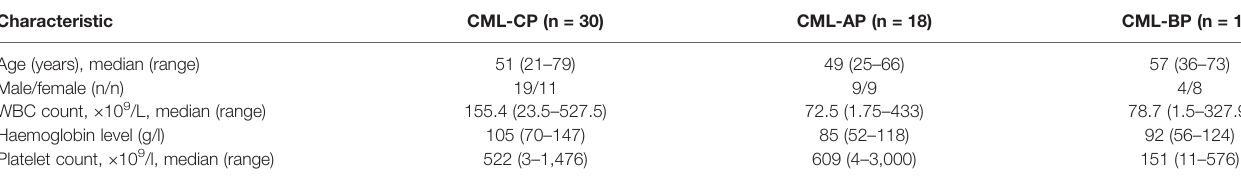
TABLE 1 | Characteristics of the patients included in the study. Characteristic CML-CP (n = 30) CML-AP (n = 18) CML-BP (n = 12) Age (years), median